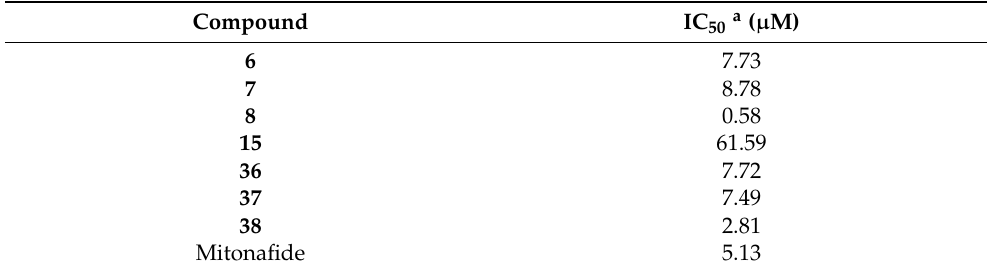
Table 4. Inhibitory properties of the tested 1,8-naphthalimide–carborane conjugates and mitonafide for human DNA topoisomerase II α